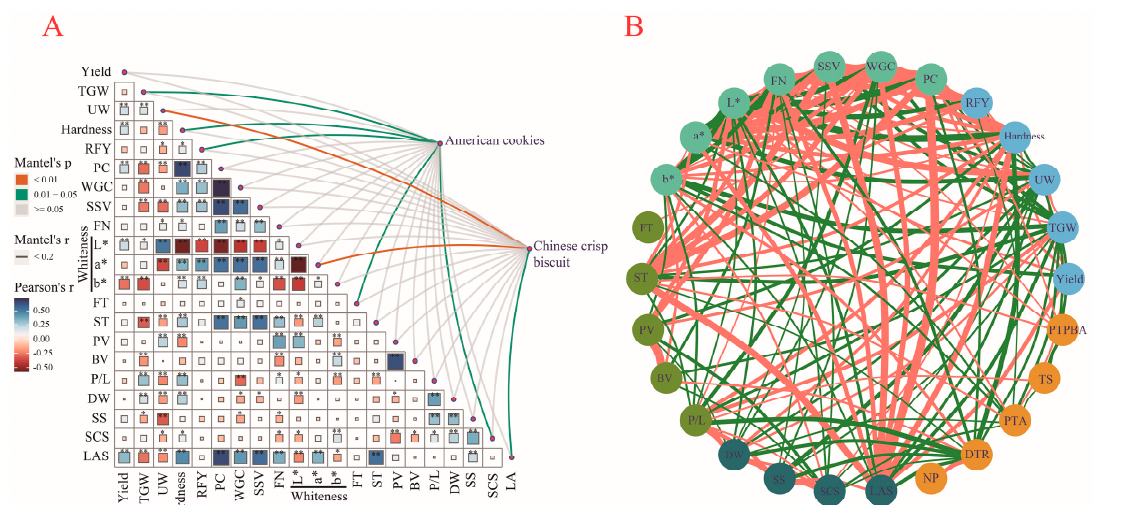
Figure 6. Pearson correlation coefficients of traits and Mantel test between cookie quality and traits. ( A ) Mantel test plot. The ** and * in the upper triangle denote the significance level of 0.01 and 0.05, respectively. ( B ) Correlation network diagram among traits. The red and green lines represent significant positive correlations and significant negative correlations at the level of 0.05, respectively. The thickness of the line represents the size of the correlation coefficient between the two traits. TGW, thousand-grain weight; UW, unit weight; RFY, rate of flour yield; PC, protein content; WGC, wet gluten content; SSV, SDS sedimentation value; FN, falling number; L*: brightness; a*: redness; b*: yellowness; FT, formation time; ST, stabilization time; PV, peak viscosity; BV, breakdown value; P/L, blowing instrument parameter. DW, SS, SCS, and LAS denoted the retention capacity of flour with de-ionized water (DW), sucrose solution (SS), sodium carbonate solution (SCS), and lactic acid solution (LAS) as the solvent, respectively. TS, tasting score; PTPBA, the parameter from the three-point bending texture analyzer; NP, number of patterns; DTR, diameter-thickness ratio; PTA, the parameter from the Texture